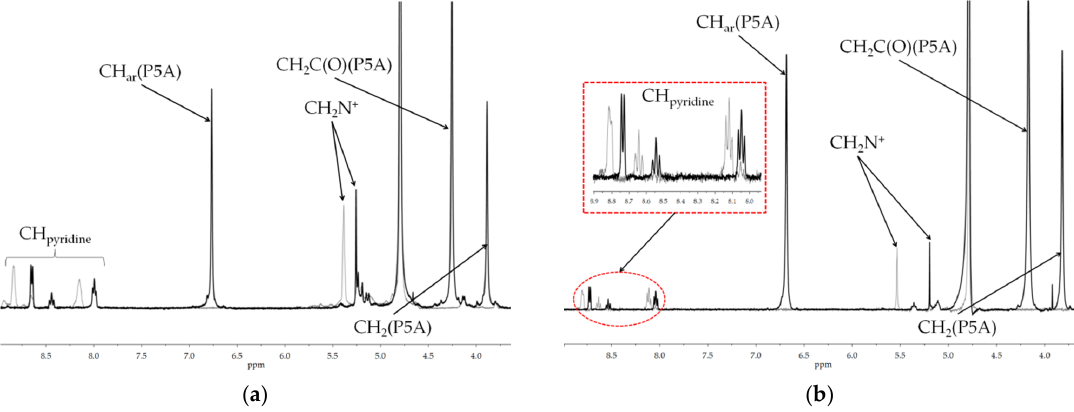
Figure 3. Fragments of 1 H-NMR spectra of systems 3a/5 ( a ) and 3b/5 ( b ) (black) and meroterpenoids 3a and 3b (gray) in D 2 O (1 × 10 − 3 M) at 298 K, 400 MHz. Table 1. Sizes of aggregates (average hydrodynamic diameter) in a methanol/water (2:1) mixture of